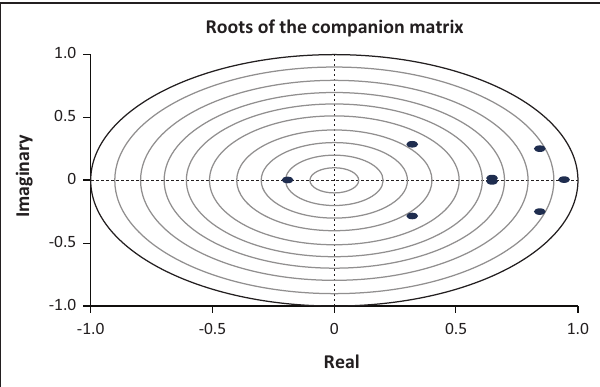
FIGURE 2-A1: Stability